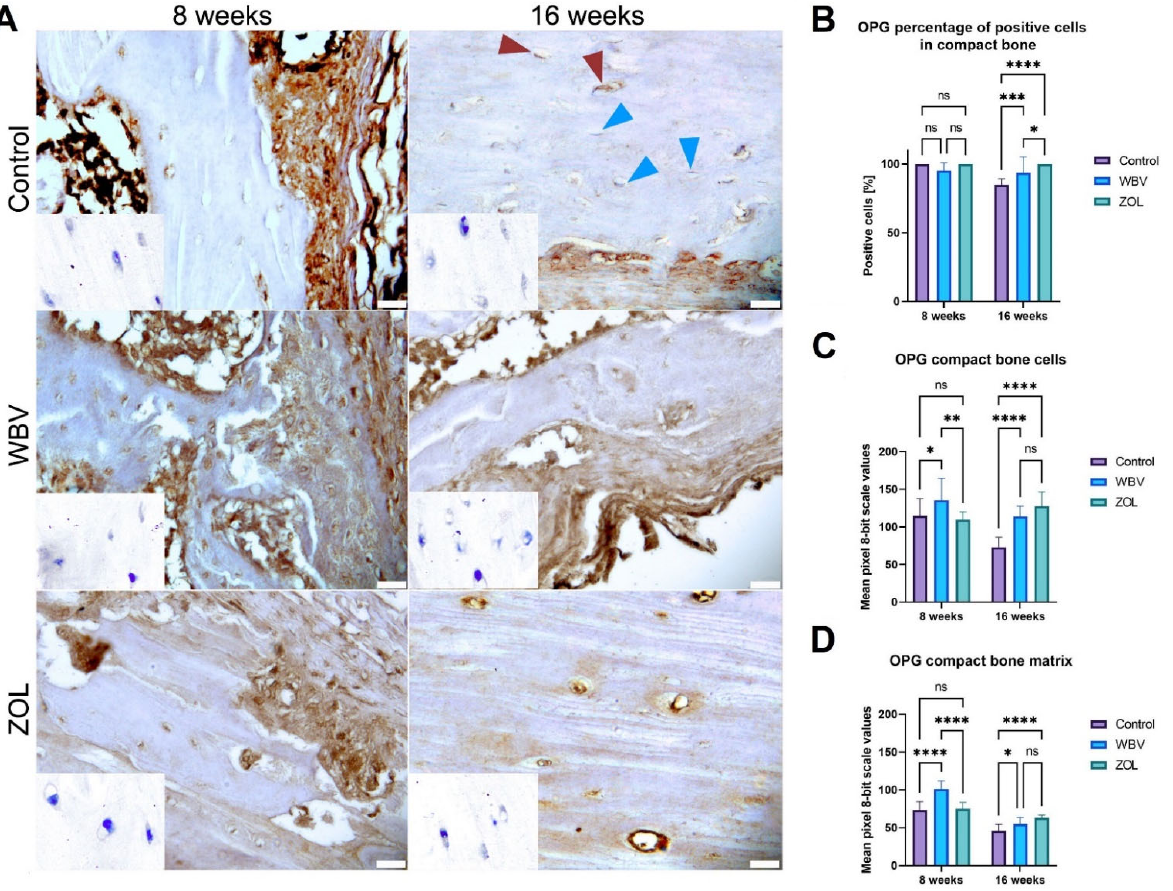
Figure 5. The immunohistochemical reaction for osteoprotegerin (OPG) in the compact bone of femora of rats subjected to obesity and immobility: ( A ) Representative images of the immunohistochemical reactions for OPG. Brown and blue arrowheads indicate examples of positive and negative reaction cells, respectively. Insets show control immunohistochemical staining without primary antibody. All scale bars represent 50 μ m; bar graphs show the ( B ) the percentage of OPG ‐ positive cells and the intensity of immunoexpression of OPG ( C ) in cells (osteocytes), and ( D ) compact bone matrix measured by the 8 ‐ bit grayscale pixel brightness value (the higher the pixel value, the higher the intensity of the immunohistochemical reaction). Data are mean values ± SD from n = 6 rats. Control—the control group included rats subjected to obesity and immobility not treated with WBV or ZOL; WBV—the WBV group included rats subjected to obesity and immobility with whole ‐ body vibration treatment (30 min, 5 days per week); ZOL—the ZOL group included rats subjected to obesity and immobility and injected intramuscularly with zoledronic acid at a dose of 0.025 mg/kg body weight every 4 weeks. Statistical significance: ns—not significant; * p < 0.05; ** p < 0.01; *** p < 0.001; **** p < 0.0001 (Tukey’s HSD test or Kruskal–Wallis H test).